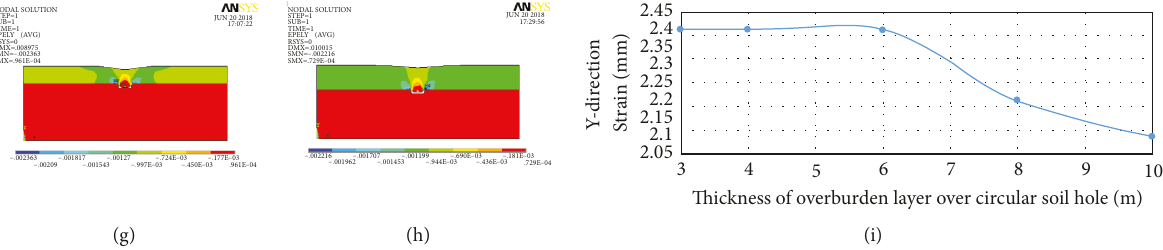
Figure 10: q � 34.66kPa scenario. Results of displacement cloud map: (a) H � 6m and (b) H � 10m; (c) displacement curve; stress cloud map: (d) H � 6 m and (e) H � 10m; (f) stress curve; strain cloud map: (g) H � 6 m and (h) H � 10m; (i) strain curve.